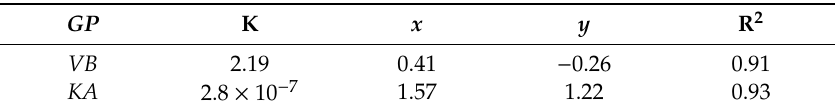
Table 5. Model coe ffi